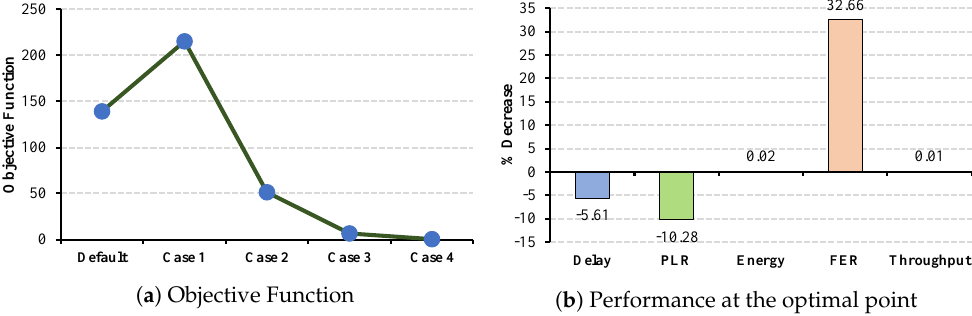
( b ) Performance at the optimal point Figure 13. EMR QoS metrics and energy consumption under CW changes for all cells.